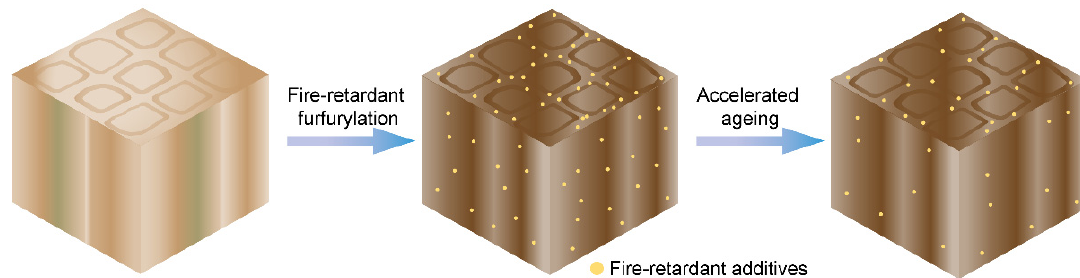
Figure 1. Schematic depiction of the research work.